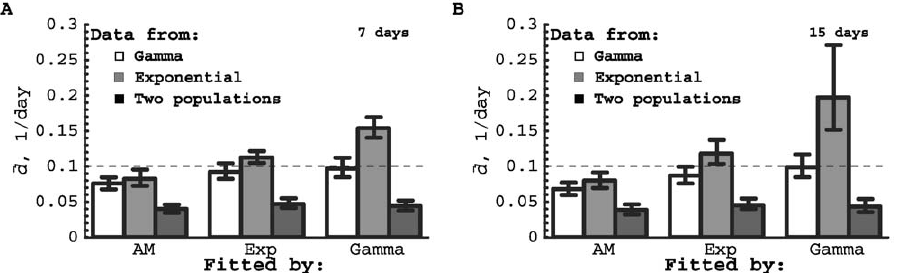
Figure 5. Average turnover rate estimated obtained by fitting mathematical models to simulated data. By fitting the artificial data described in the text, we estimated the average turnover rate using three models: the Asymptote model (eqn. (1)), the Exponential model (in which a fraction a of cells have exponentially distributed turnover rates, eqn. (8)), and the Gamma model (with gamma-distributed turnover rates, eqn. (4)). Estimated mean values and 95% confidence intervals obtained by bootstrapping the residuals with 1000 simulations are shown. Data were generated using the Gamma model (empty bars), the Exponential model (gray bars) and the Two-populations model (black bars). Labeling periods were 7 (panel A) and 15 (panel B) days. Horizontal dashed lines denote the actual average rate of lymphocyte turnover in all data, (cid:1) dd ~ 0 : 1 /day. Note that in this example, the Asymptote model always underestimated the average rate of cell turnover, and that there is a systematic 2-fold underestimation of the average turnover by all models when the data from the Two-populations model were fitted. This is because all three models fail to describe the relatively rapid accumulation of the label at early time points (see Figure 4E–F).